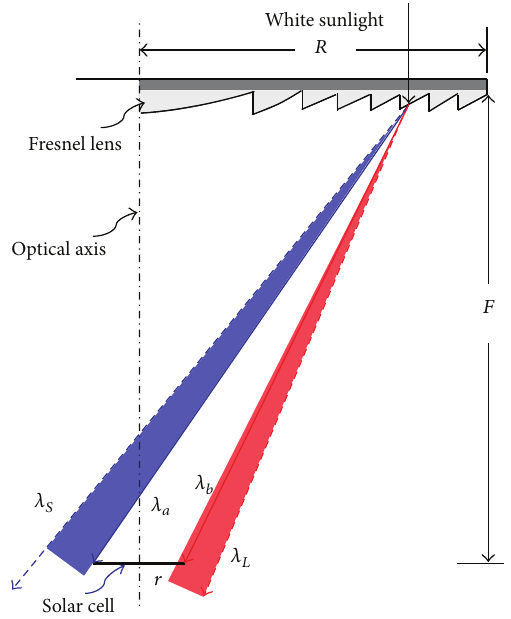
Figure 3: Plot of sunlight dispersion through an arbitrary groove of aFresnellenswithaspectratio1.2,geometricalconcentration1200X, and design spectrum 350–1750 nm. It is noted that the dimensions of cell and spectrum are locally exaggerated.